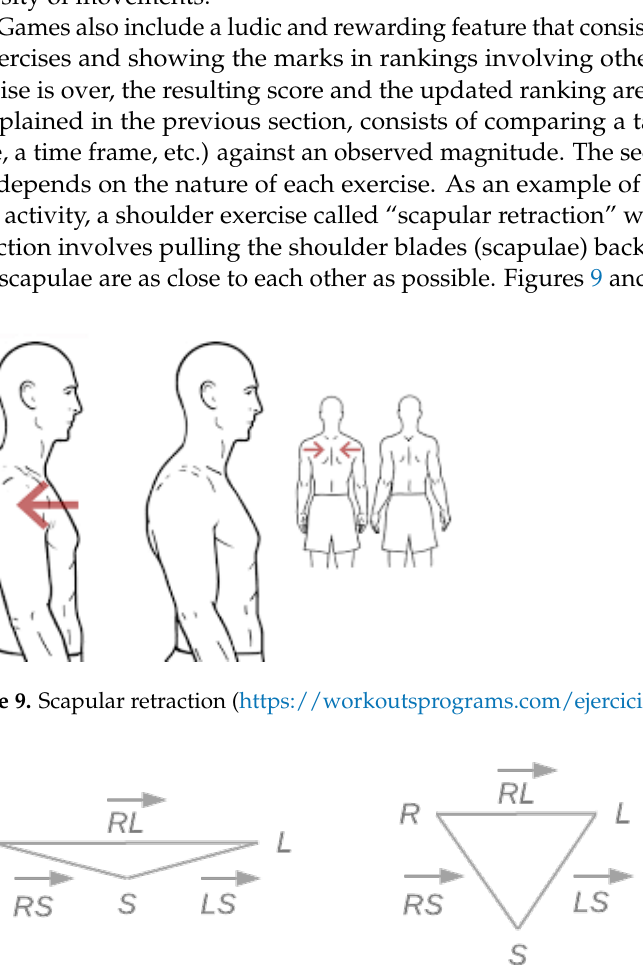
Figure 10. Triangle defined by the joints SHOULDER_RIGHT, SPINE_SHOULDER, and SHOUDER_LEFT (from a top view). On the left, a representation of the resting state of these joints. On the right, deformation caused by the correct execution of a scapular retraction.